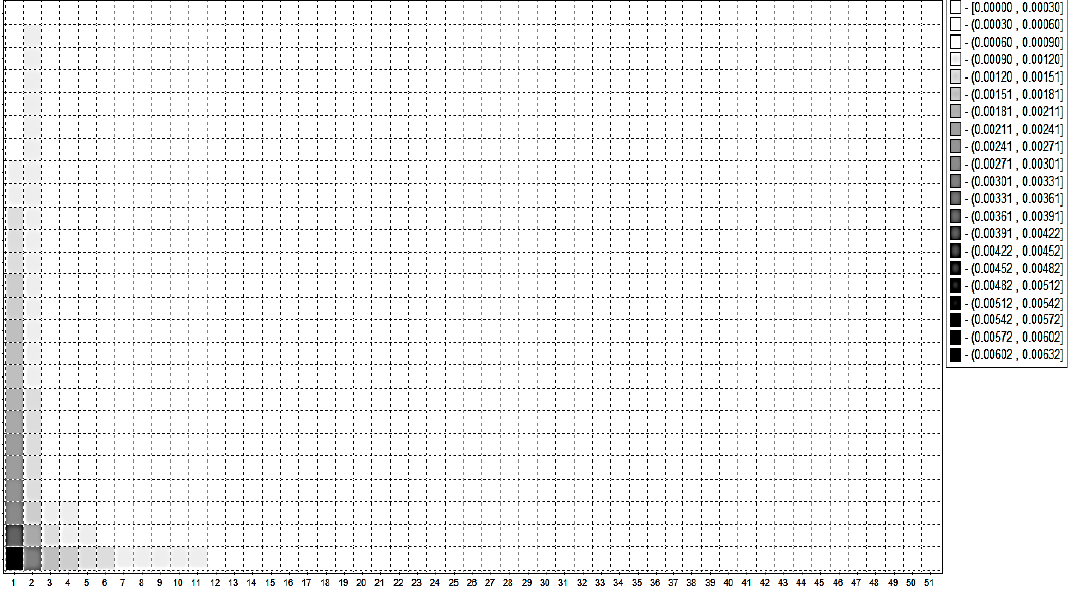
Figure 12. Moving periodogram matrix of reconstructed components.